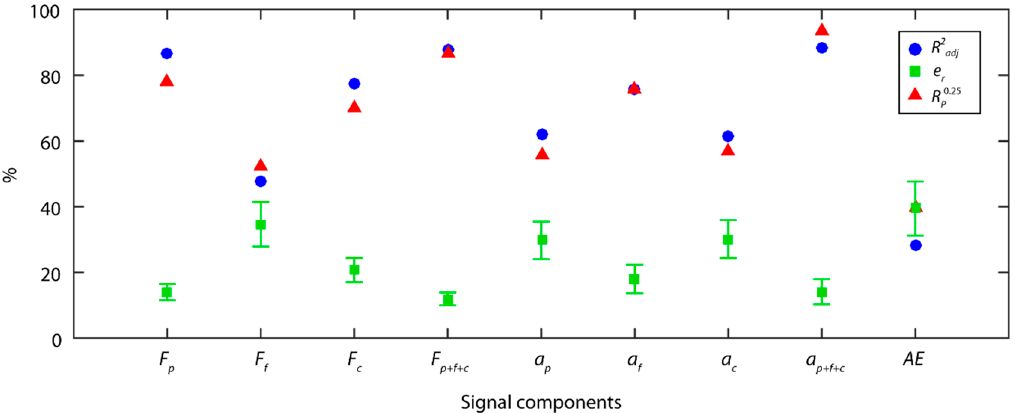
Figure 14. Signal analysis results with the WPT method.